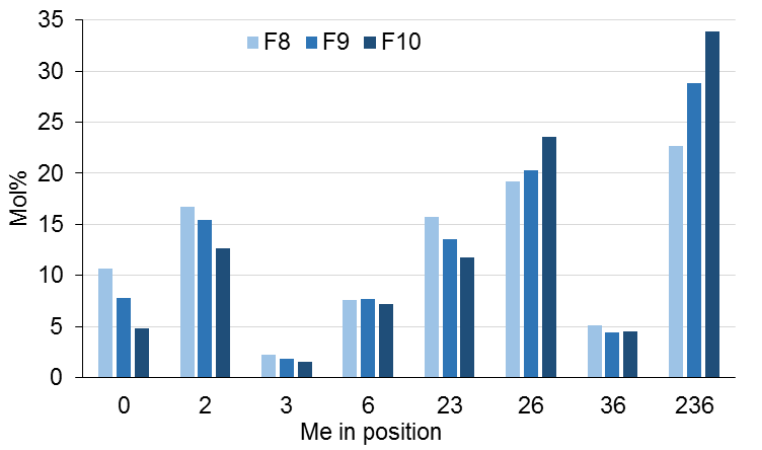
Figure 10. Methyl distribution in the glucosyl units of the main fractions obtained by semi- prepar- ative fractionation of MC (DS 1.91) as MC-MeOBz by gradient HPLC on silica with DCM/2-PrOH gradient as shown in Figure 9. DS: 1.75 (F8), 1.88 (F9) and 2.03 (F10). Average DS values have also been calculated from the corrected peak areas of a sam- ple separation. For this correction, dependence of the ELSD signal from the solvent com- position has been determined. It increased with the 2-PrOH portion up to a volume of ca.